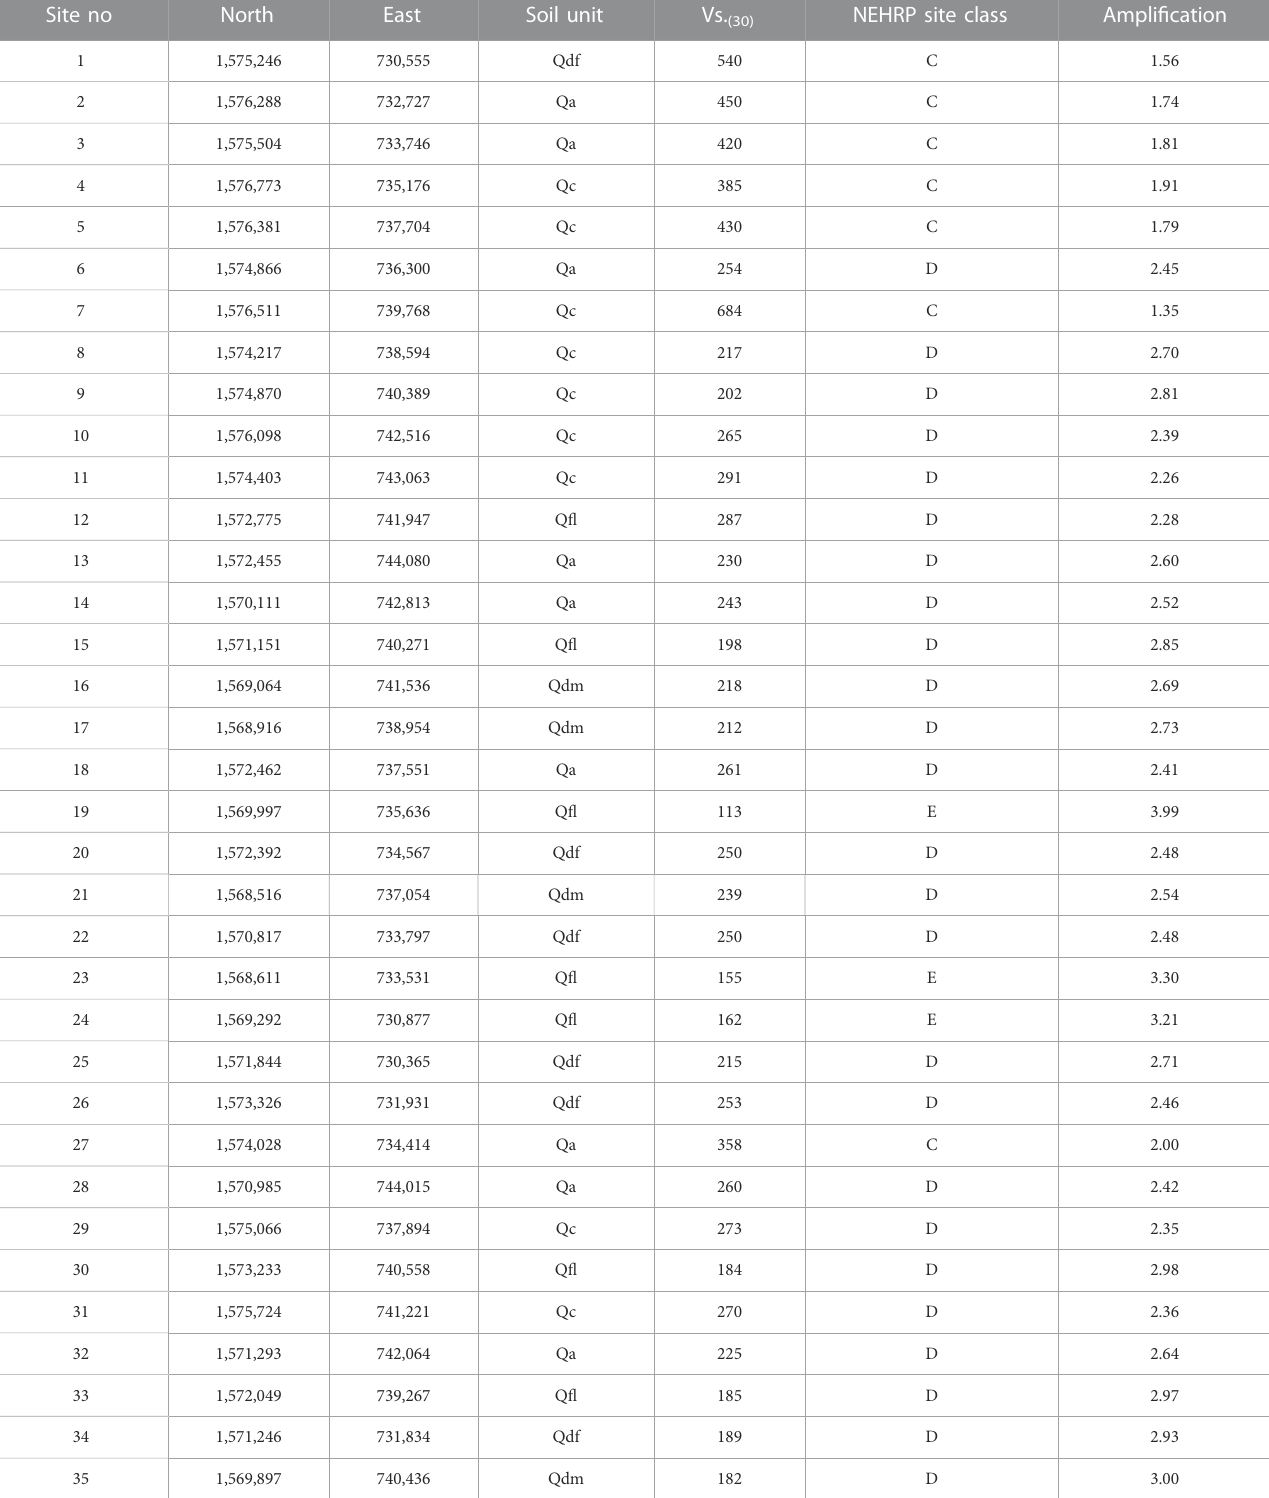
TABLE 2 The NEHRP site classi fi cation for each test